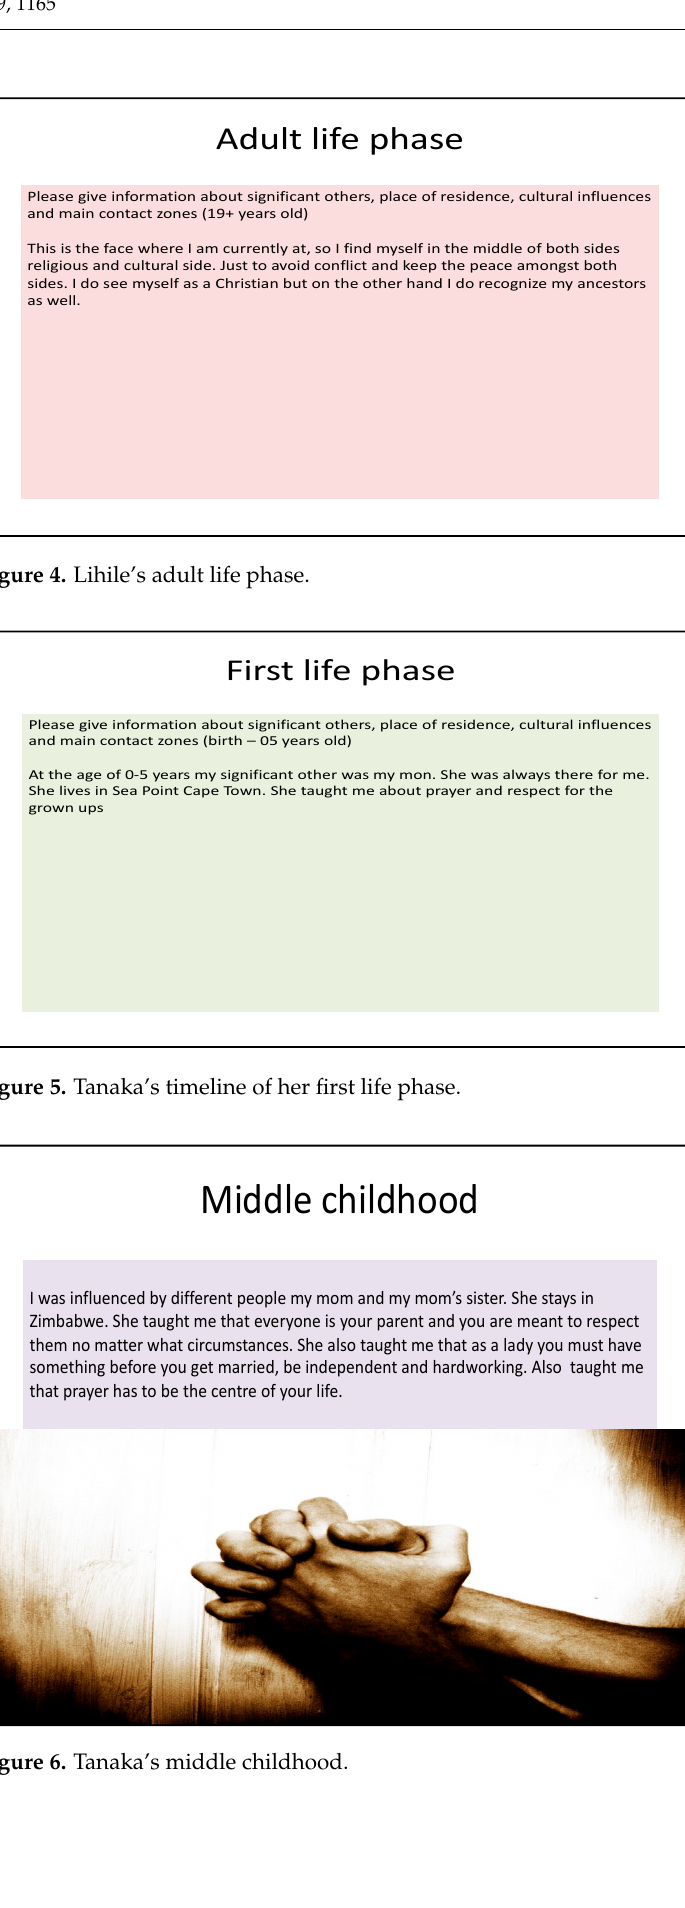
Figure 7. Tanaka’s adult life phase.